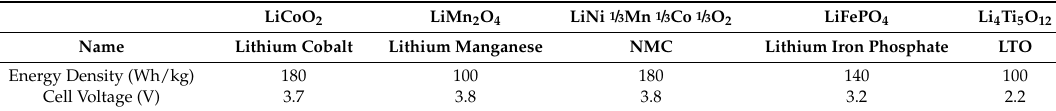
Table 1. Example of cell voltage for Li-ion